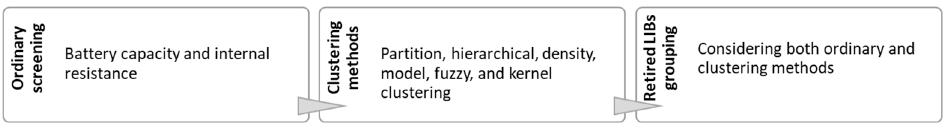
Table 5. Summary of clustering methods along with their objectives for EV battery grouping. Method Used